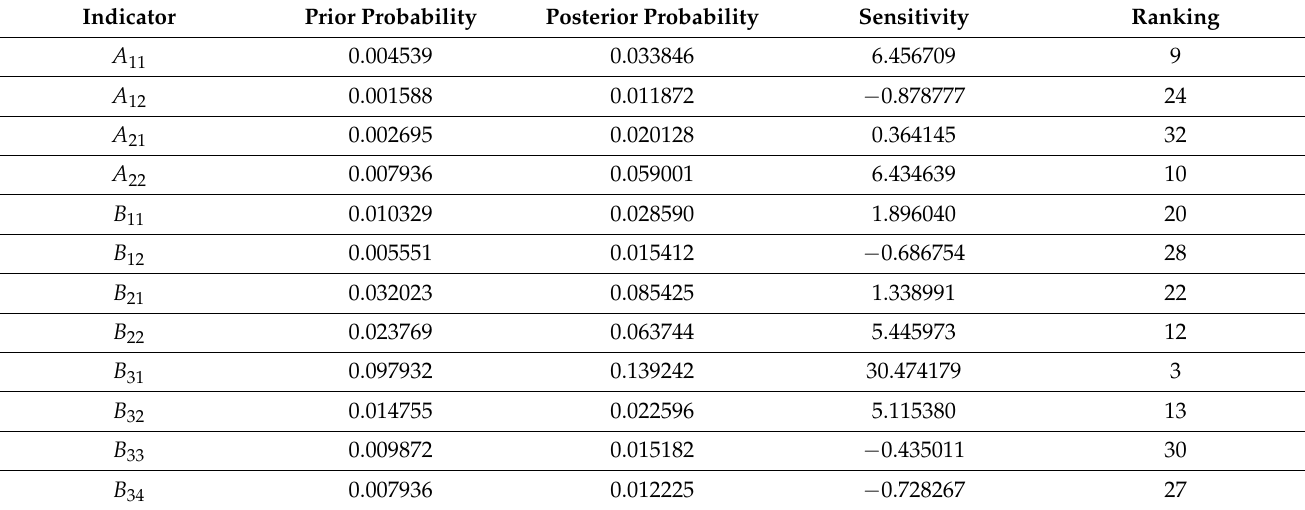
Table 10. Risk factor sensitivity and ranking of each node (third-level